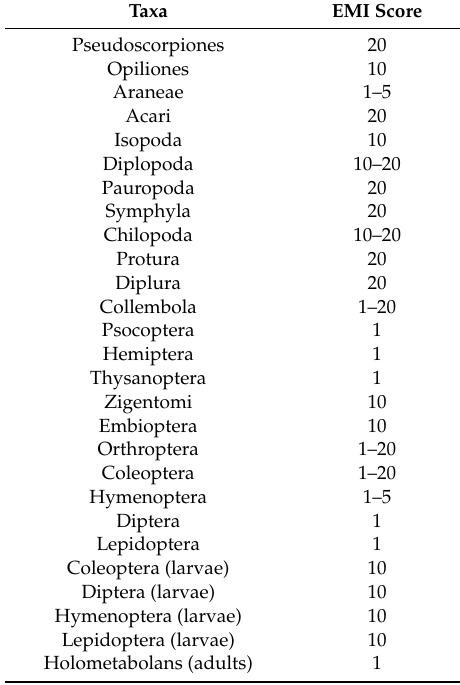
Table A2. Eco-morphological Indexes (EMIs) score for each microarthropod taxa. Groups shown are those found in this